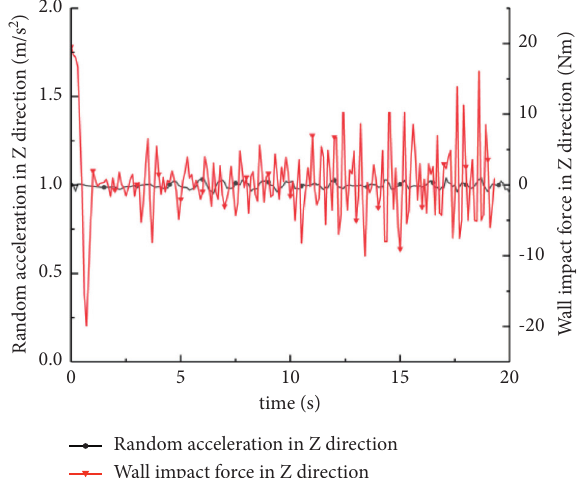
Figure 7: Relationship between stochastic acceleration and impact